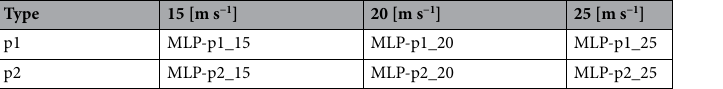
Table 1. Configuration of Artificial Neural Networks based on air velocity and position of the seminal-air tube.